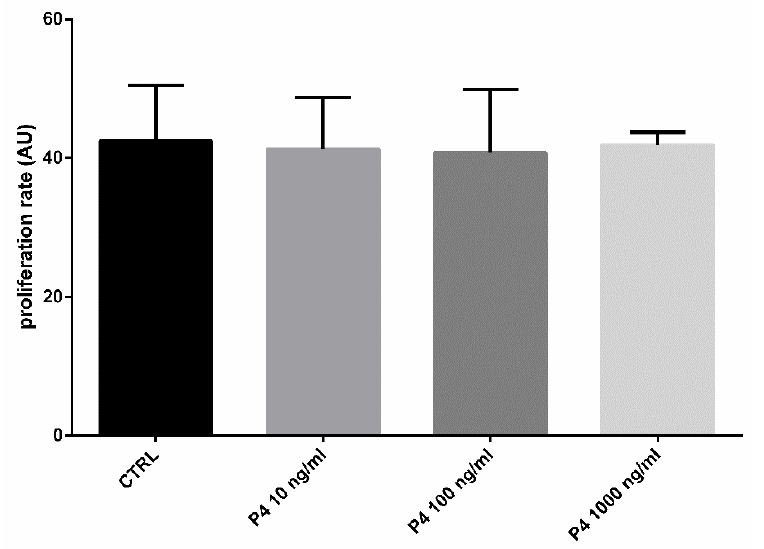
Figure 2. Effect of the different P4 concentrations on SOECs doubling time. The histograms show a normal proliferation rate of the samples treated with different concentrations of P4 (10, 100 and 1000 ng/mL), similar to the control (CTRL) group ( p > 0.05). Three independent experiments were performed.